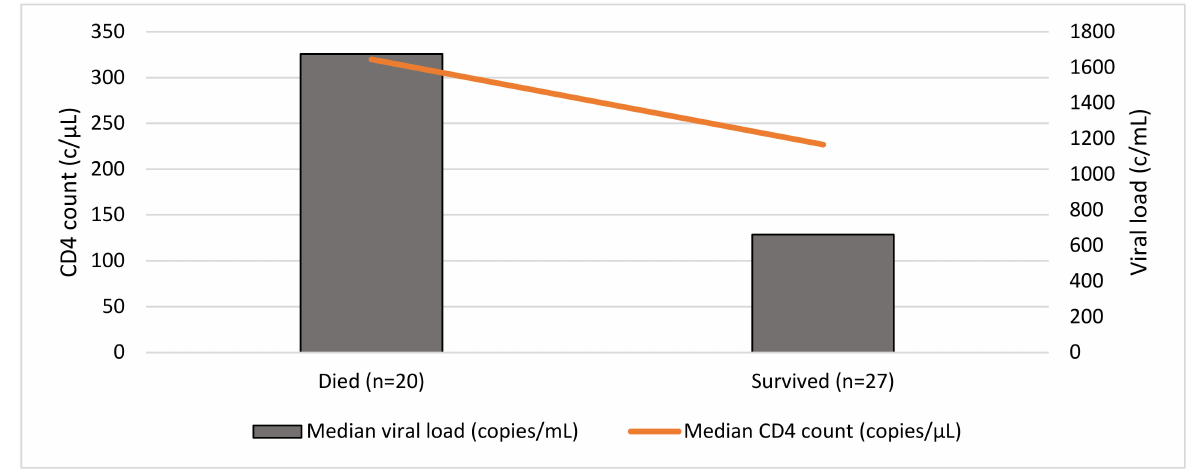
Figure 2. Baseline CD4 count and viral load at presentation and outcome ( n = 47).